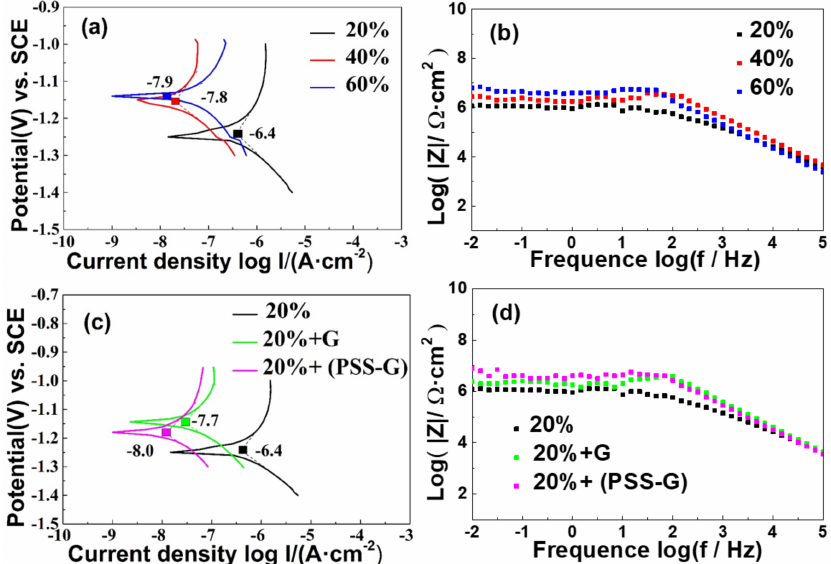
Figure 7. ( a , c ) Tafel polarization curves and ( b , d ) Bode plots of coatings with di ff erent zinc contents, pure coating, G / coating and PSS-G / coating with 20% zinc content. (The black line, red line, blue line are for the zinc-containing coatings with zinc content of 20%, 40% and 60%, respectively. The green line is for epoxy / G coating, the violet line is for epoxy / PSS-G